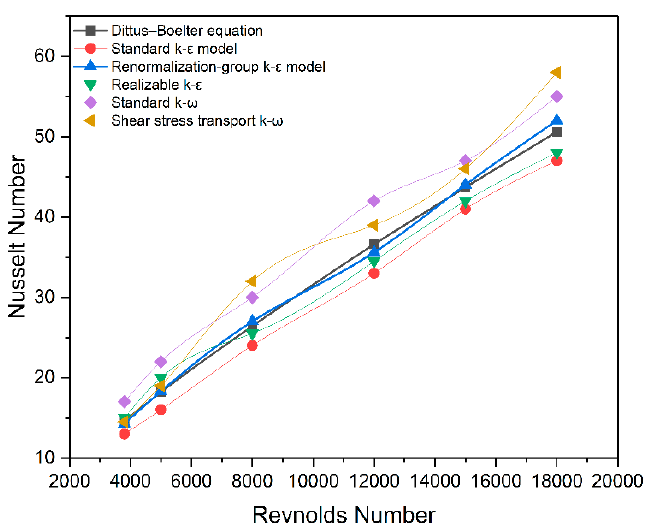
Figure 3. Comparison between the variation in the Nu r with Re for different turbulence models.